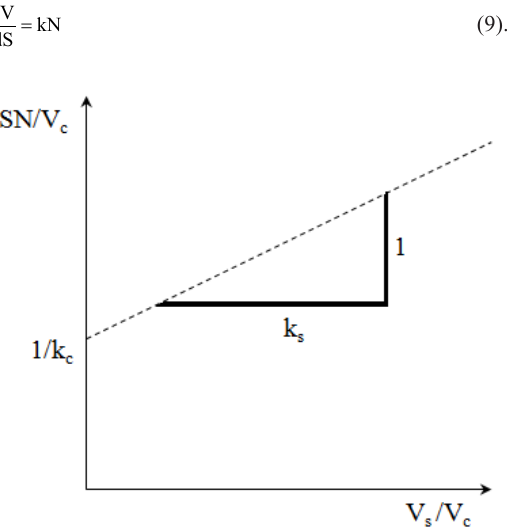
Figure 2. Schematic diagram showing linear plot obtained by plotting S.N/Vc against Vs/Vc.